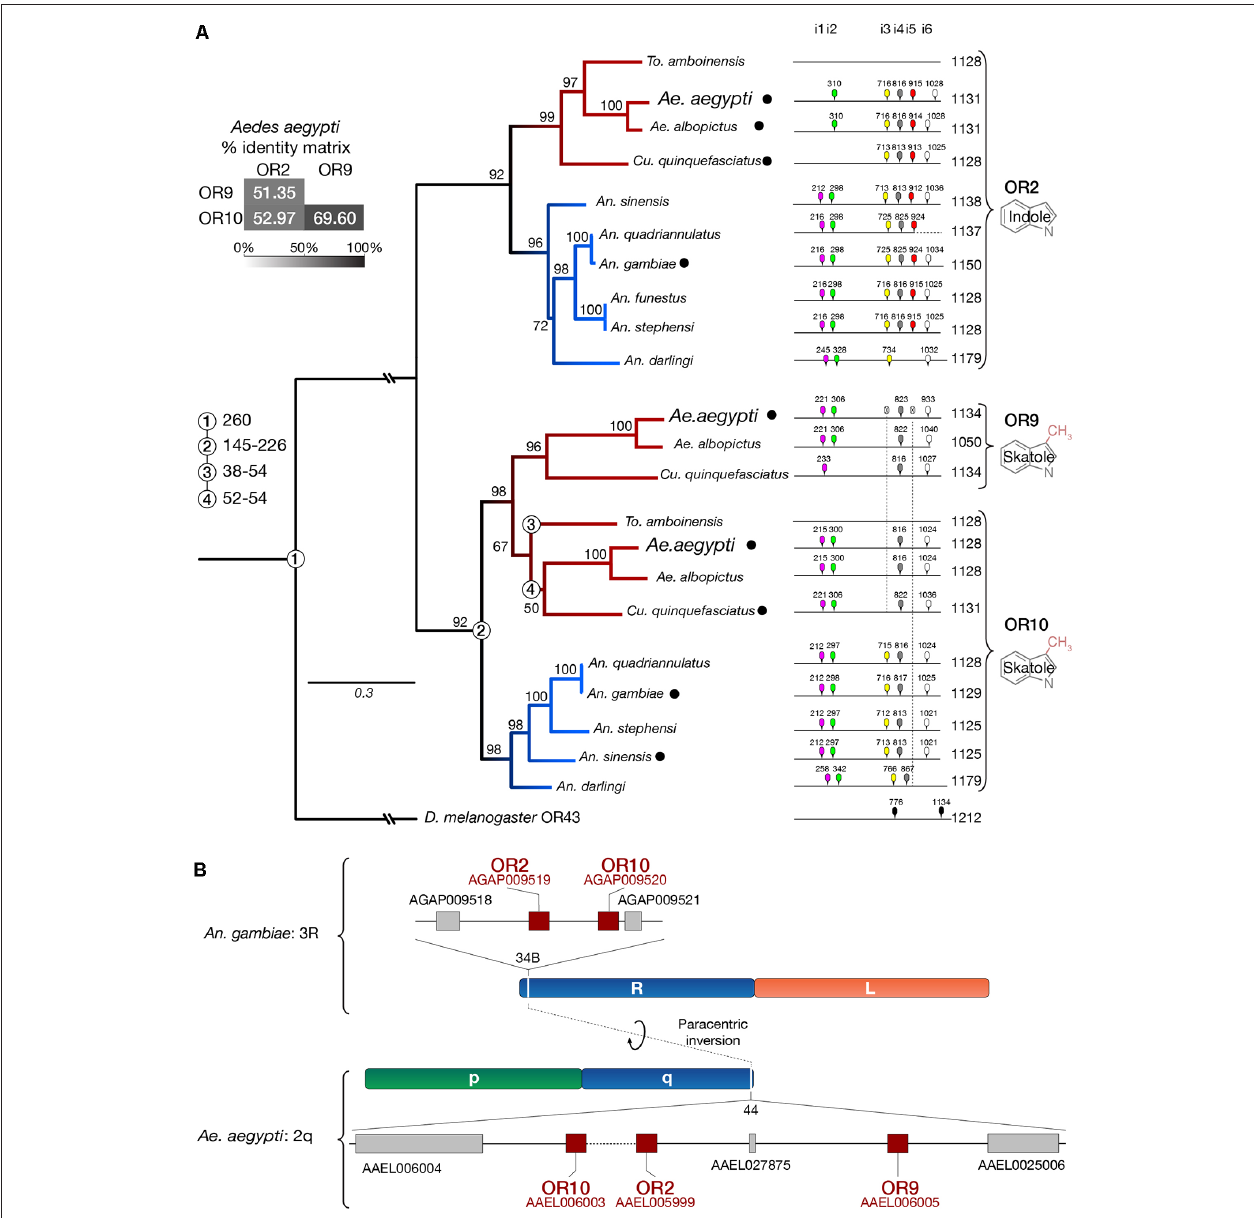
FIGURE 3 | Or9 is a Culicinae-specific gene expansion. (A) DNA sequence identity, substitution rates, intron locations and odorant ligands (deorphanized receptors are labeled with a black dot, see Supplementary Table 2 ) suggest that Or9 is a Culicinae-specific gene expansion while Or2 and Or10 are present in both Culicinae (red branches) and Anophelinae (blue branches). Intron locations are color-coded and numbered from 1 to 6 (i1–i6). Missing introns are indicated by a crossed intron with a dotted lines underneath. Bootstrap values (%) are based on 5,000 replicates. Numbered circles on branch points indicate lineage splits in million years (MY). (B) Indolergic receptors are located on the q arm of chromosome 2 and on the R arm of chromosome 3 in Ae . aegypti and An . gambiae , respectively. Transcript numbers are shown for An. gambiae (AGAP#) and Ae. aegypti (AAEL#).